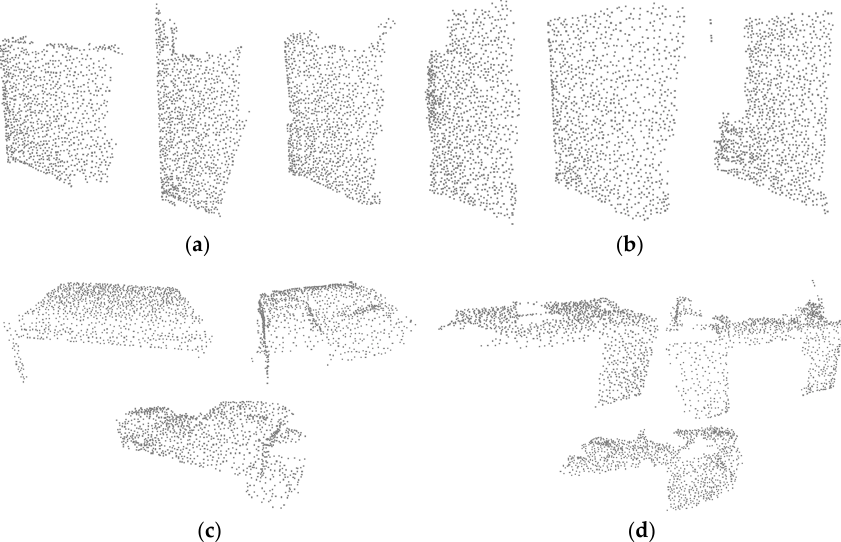
Figure 5. Examples of object categories with similar characteristics in ScanObjectNN-11. ( a ) Cabinet. ( b ) Door. ( c ) Bed. ( d ) Desk.